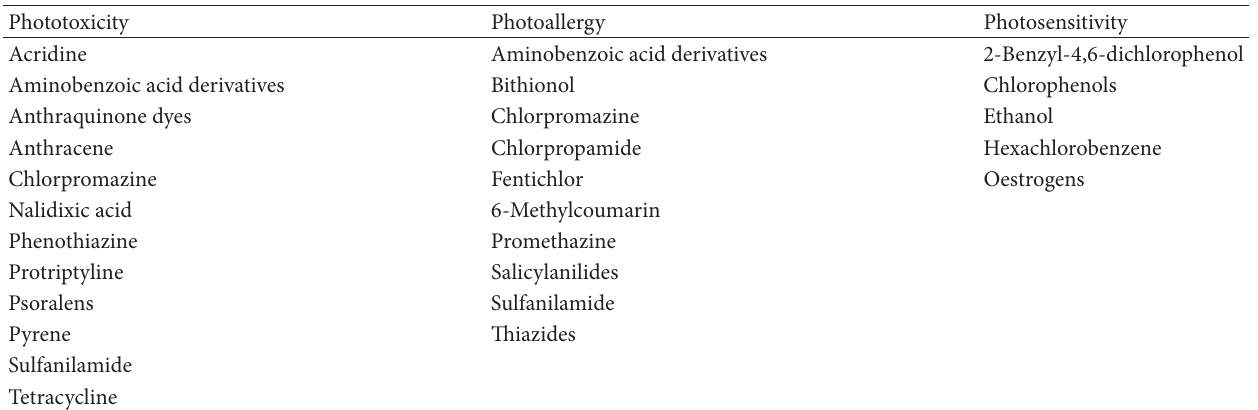
Figure 13: Photoinduced ring cleavage reaction of norfloxacin. Table 1: Drugs causing adverse biological